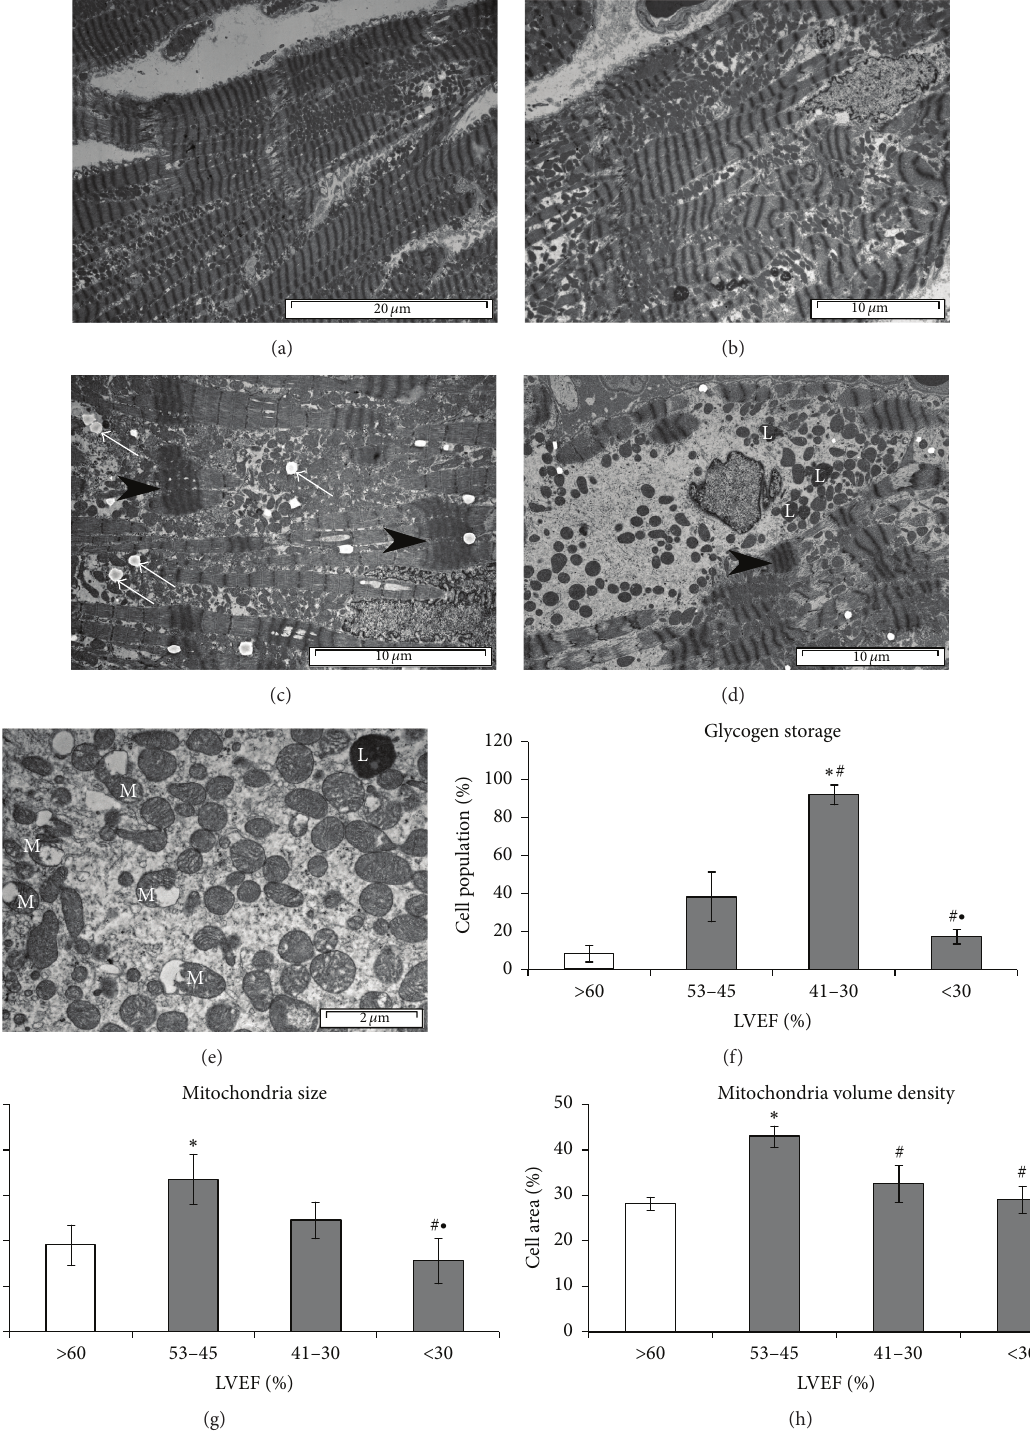
Figure 3: Cardiomyocyte ultrastructural remodeling during heart failure progression. Representative images for (a) control heart. Cardiomyocytes with normal ultrastructure and oval mitochondria arranged in rows. (b) Heart Group (I) (LVEF 53–45%). Cardiomyocyte withincreasednumberofvarioussizemitochondriaarrangedinclusters,partiallymissingcontractileapparatus,incidenceofdilatedT-tubule. (c)HeartGroup(II)(LVEF41–30%).Cardiomyocytewithmissingcontractileapparatusandcontractionbands(blackarrowheads),numerous polymorphic mitochondria, lipid droplets between mitochondria (white arrows), and (d) Heart Group (III) (LVEF < 30%). Cardiomyocyte with severe loss of contractile fibrils and contraction band (black arrowhead), scattered mitochondria, and lipofuscin granules (L). (e) Impaired mitochondria (M) in hearts with LVER < 30%; results of morphometric analyses. (f) Glycogen storage. (g) Mitochondria size. (h) Mitochondria volume density. Results as mean ± SEM; ∗ 𝑝 < 0.05 versus control; # 𝑝 < 0.05 versus Group (I); ∙ 𝑝 < 0.05 versus Group